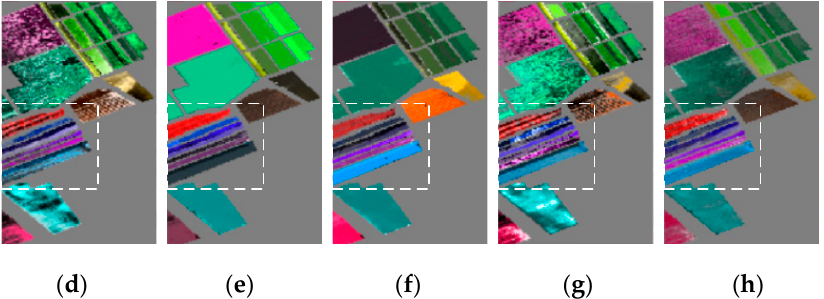
Figure 7. Visualization result for Salinas. ( a ) PCA; ( b ) CMF; ( c ) band selection; ( d ) T-SNE; ( e ) LTSA; ( f ) LLE; ( g ) LE; ( h ) ISOMAP.